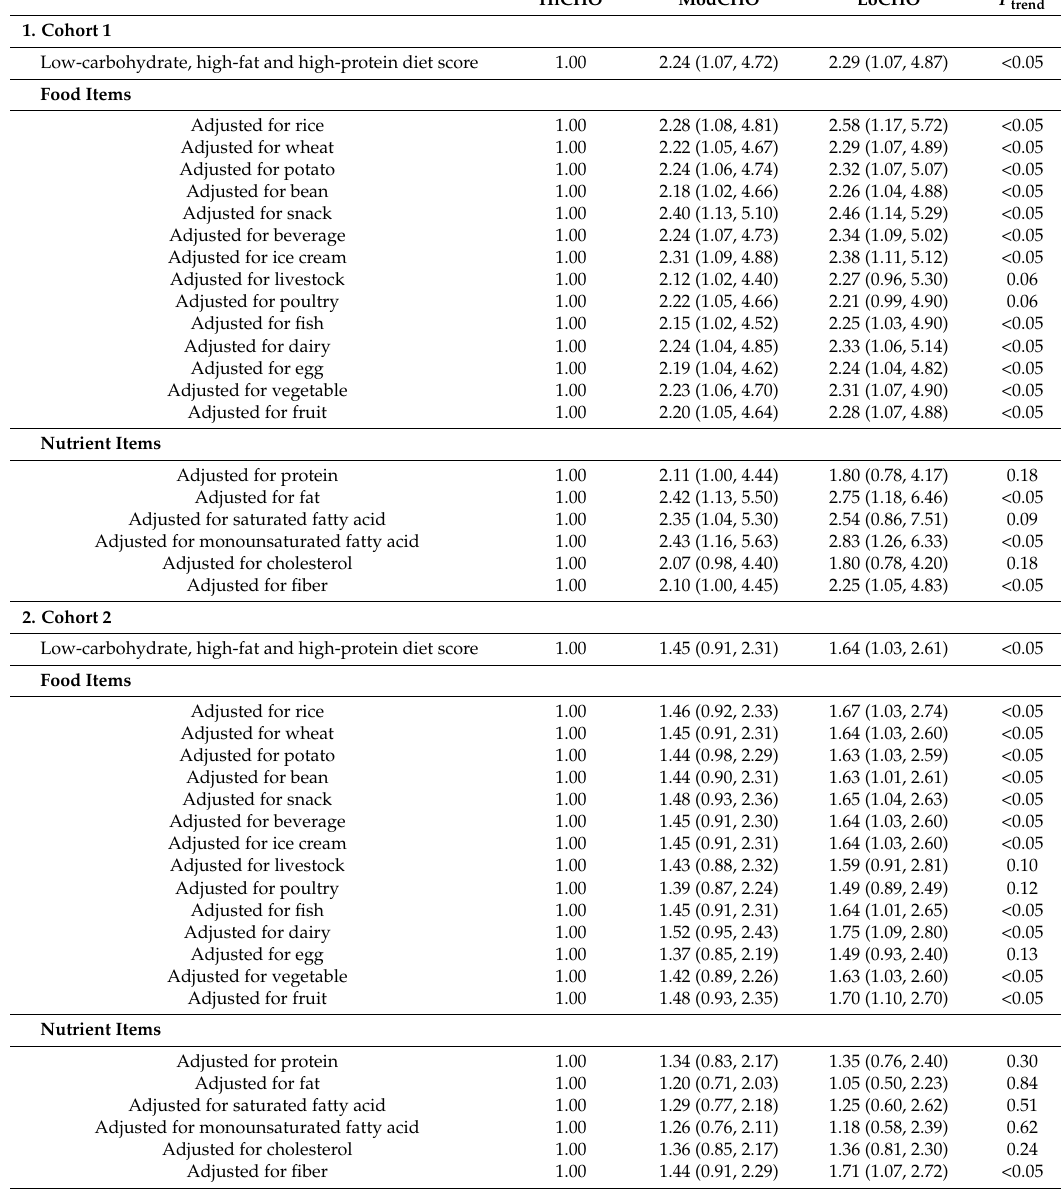
Table 5. Relative risk (95% Confidence interval) of type 2 diabetes across tertiles of low-carbohydrate, high-fat and high-protein diet scores after adjustment for foods and nutrients in the population consuming extra calories of the Harbin People’s Health Study (Cohort 1, 2008–2012) and Harbin Cohort Study on Diet Nutrition and Chronic Non-Communicable Diseases (Cohort 2, 2010–2015). HiCHO ModCHO LoCHO P